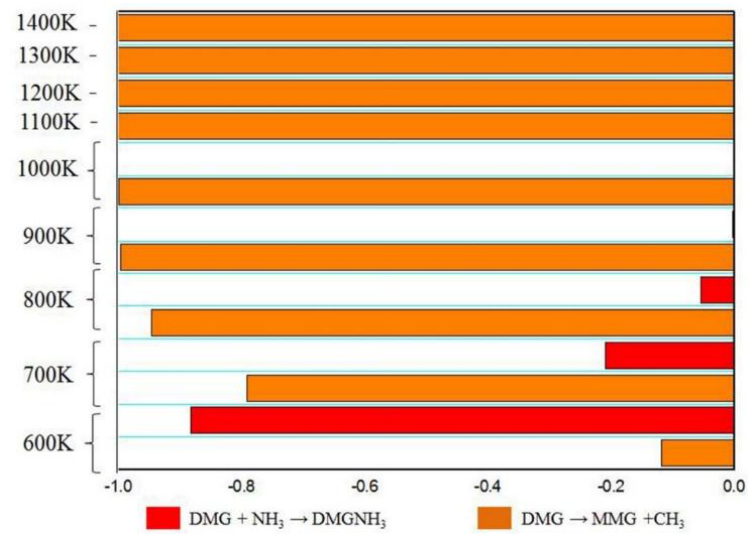
Figure 6. ROP analysis for TMG in the gas phase.